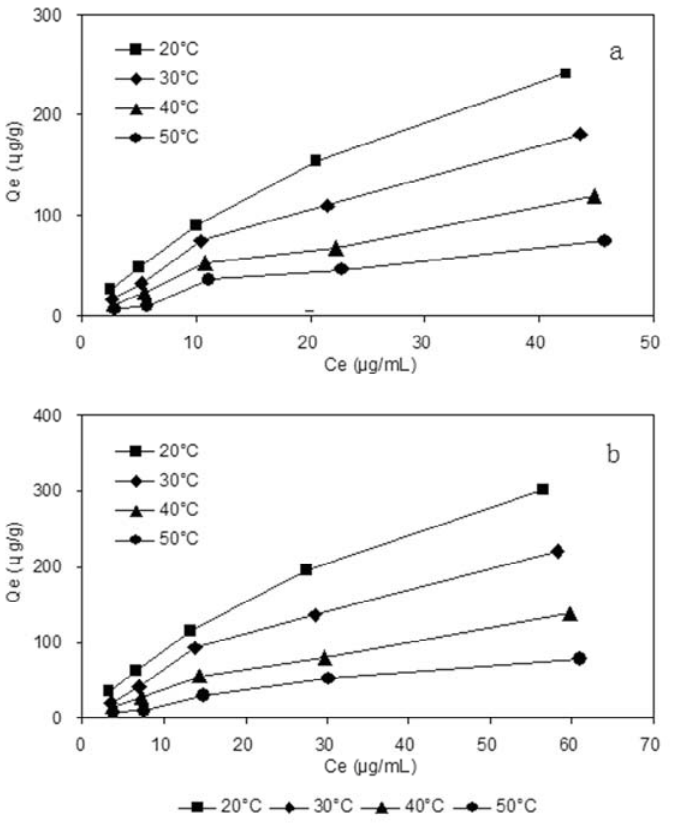
Figure 3. Adsorption isotherms of deoxyschizandrin ( a ) and γ -schizandrin ( b ) on HPD5000 resin at different